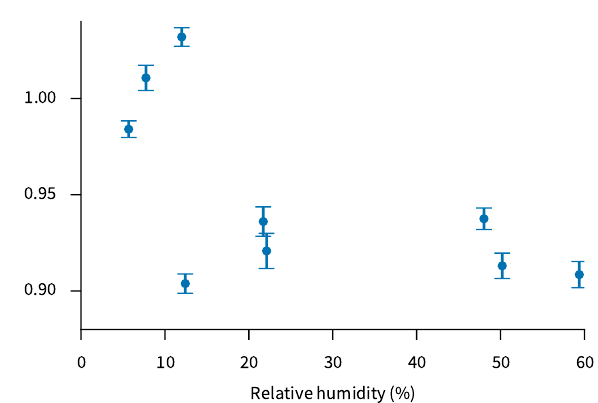
Figure 4. Ratio of polonium–218 to –214 counts (related to the re- coil probability, p r ) during pulse injection tests as a function of the average relative humidity within the detector for the first hour since pulse injection. The Bayesian deconvolution approach (Sect. 3.3) was used to fit the model to observations by specifying a known ambient radon concentration. The markers show mean ± one stan- dard